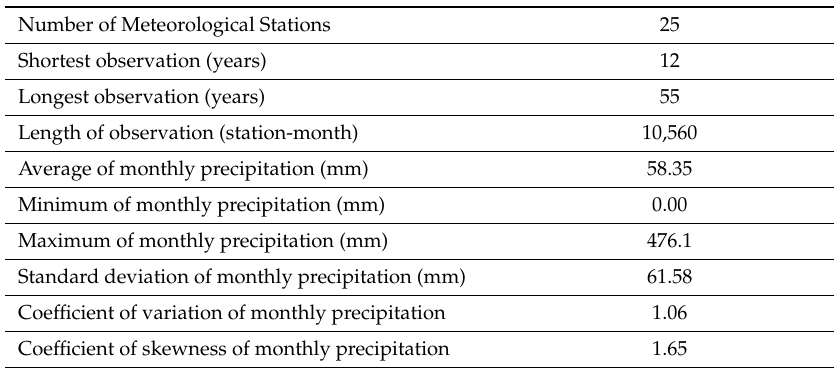
Table 3. Monthly precipitation data used in the